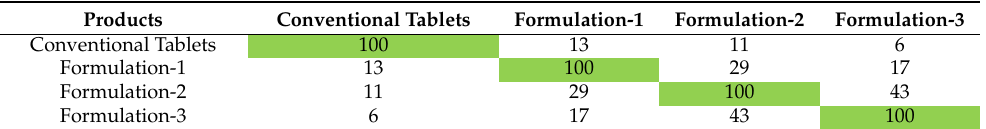
Table 6. Values of the similarity factor ( f 2 ) of conventional tablets and controlled-release tablets of